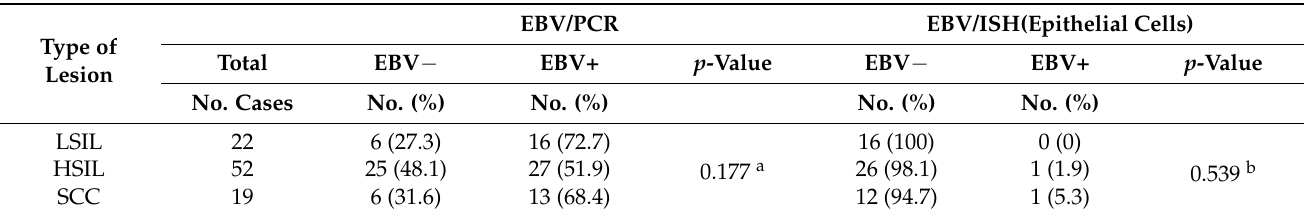
Table 3. Frequency of EBV infection according to grade of cervical lesions.